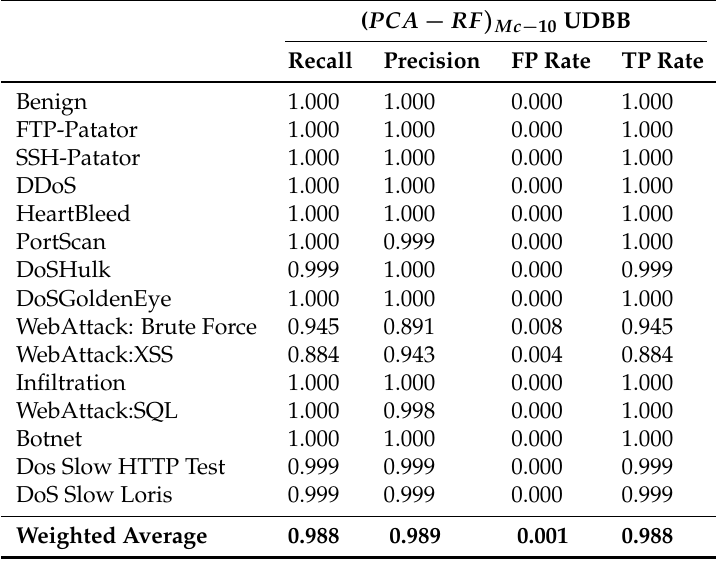
Table 13. Performance evaluation after applying